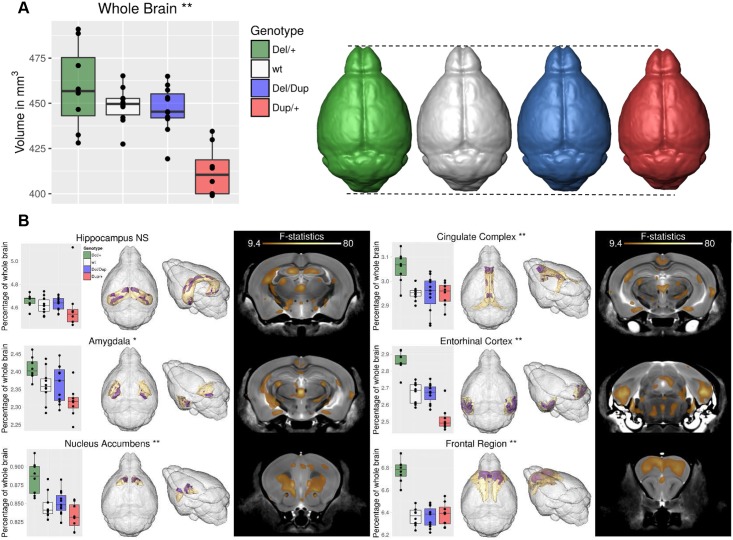
Differences in whole brain volume and relative volumes (normalized or overall brain volume) for the hippocampus, amygdala, nucleus accumbens, cingulate complex, entorhinal cortex and the frontal region of the 17q21.31 mouse models.All plots use box-and-whiskers diagrams. The box indicates data that lie within the 25th and 75th percentile. The horizontal line in the box specifies the median of the data, and the whiskers the full range of the data with the individual dots being the outliers. (A) Total brain volume is significantly different between the 4 genotypes at 0.1% FDR. (B) Relative volumes. For each structure, the following data are shown: on the left a bar graph indicating the relative size of the entire structure/region expressed as a percentage of total brain volume. Significance is based on the f-statistic resulting from comparing the 4 genotypes. NS = not significant, * = significant at 1% FDR, ** = significant at 0.1% FDR. In the center, the 3D surface renderings focus on significant changes for the structure of interest only. In grey the surface of the entire brain, in yellow the surface of the structure/region of interest and in purple all areas inside that structure/region that are significantly different between the genotypes at 0.1% FDR. On the right is a coronal slice through the average MR brain image. All colored regions indicate areas where the relative volume is significantly different between the 4 genotypes at 0.1% FDR. Cohort used included 8 Del/+, 10 wt, 11 Del/Dup, and 8 Dup/+ animals.